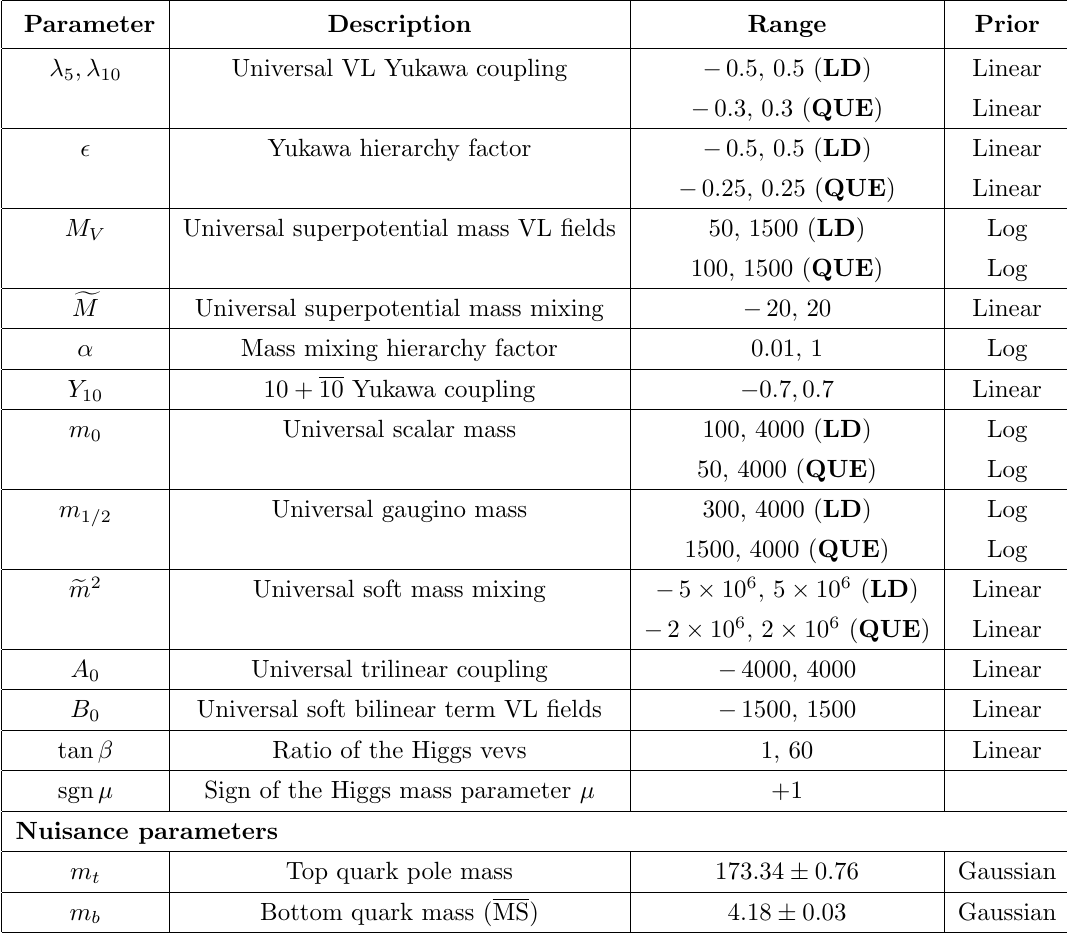
Table 4. Parameters of the models analyzed in this work. All soft SUSY-breaking masses are de(cid:12)ned at the GUT scale. Dimensionful quantities are given in GeV and GeV 2